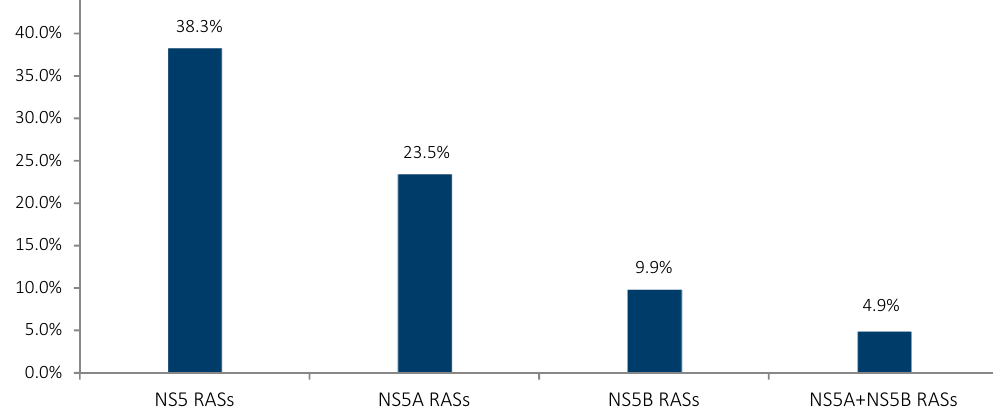
Figure 2. Baseline prevalence of NS5 RASs in all GT1 HCV-infected patients. Substitution analyses were conducted on Sanger sequencing data with a 15% cut-off limit. Dual-class RASs are assigned as NS5A + NS5B RASs.